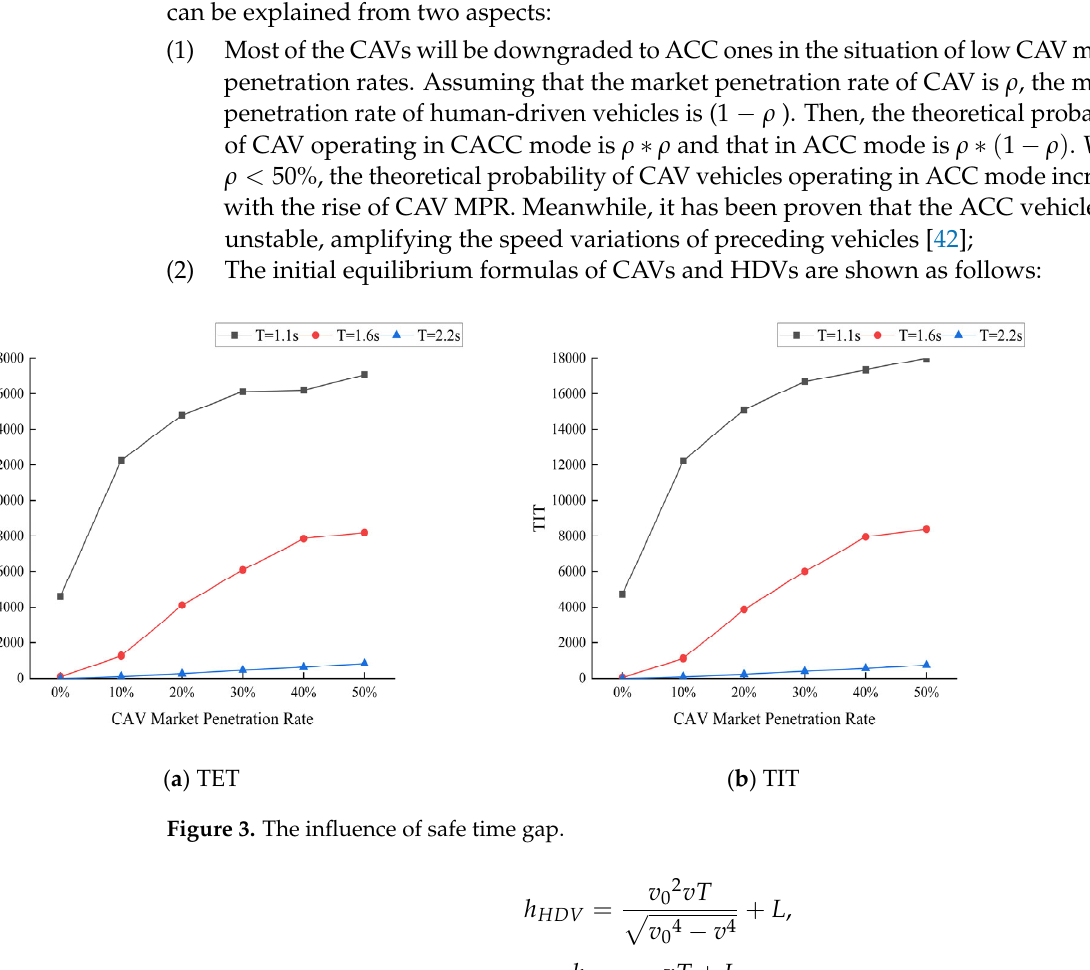
Figure 3. The influence of safe time gap.